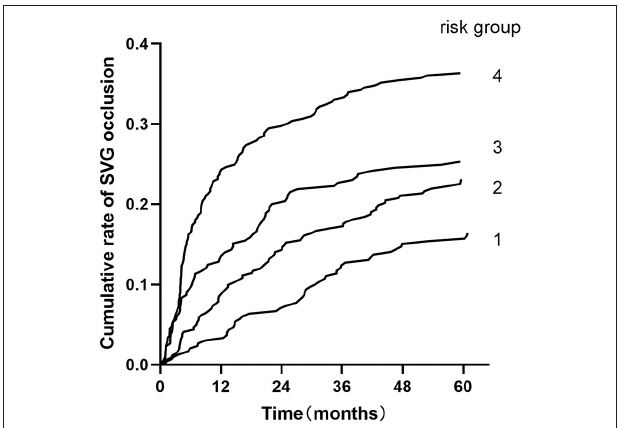
FIGURE 1 | Cumulative rate of SVG occlusion for patients classified into four groups based on the developed risk score. Risk groups 1-4 represent risk scores ≤ 5, 6-10, 11-13, and ≥ 14. SVG, saphenous vein graft.